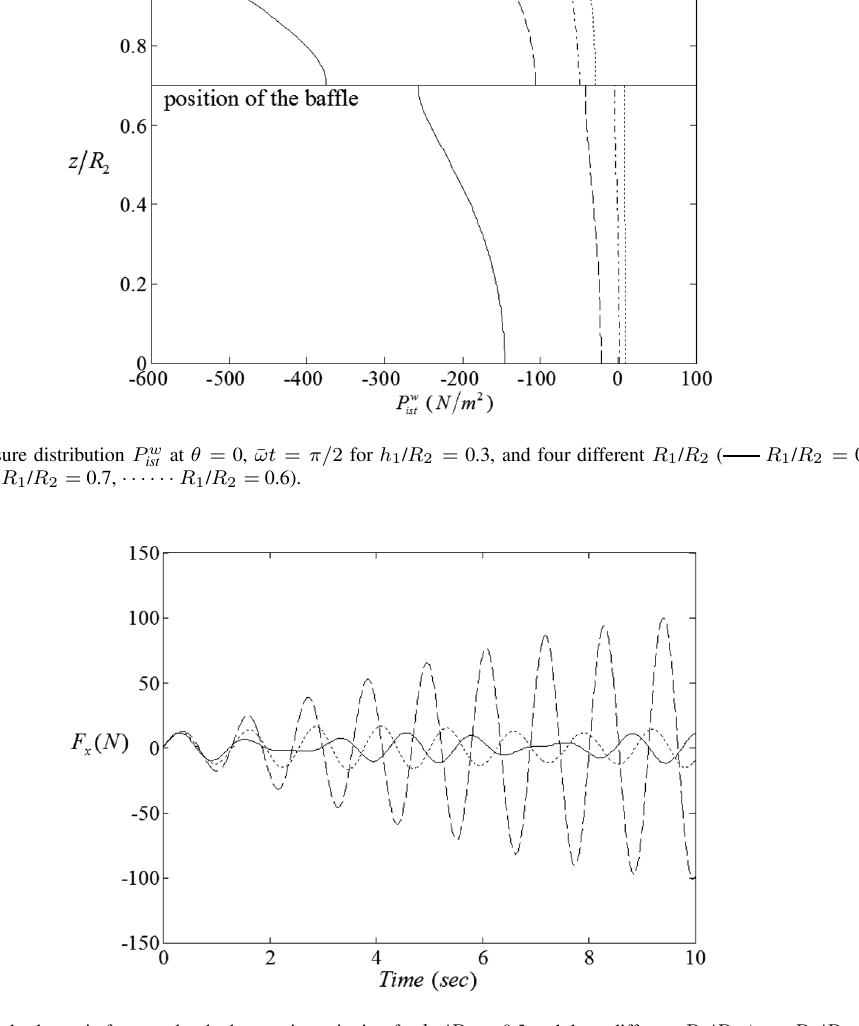
Fig. 7. The resultant hydrodynamic force under the harmonic excitation for h 1 / R 2 = 0.3 and three different R 1 / R 2